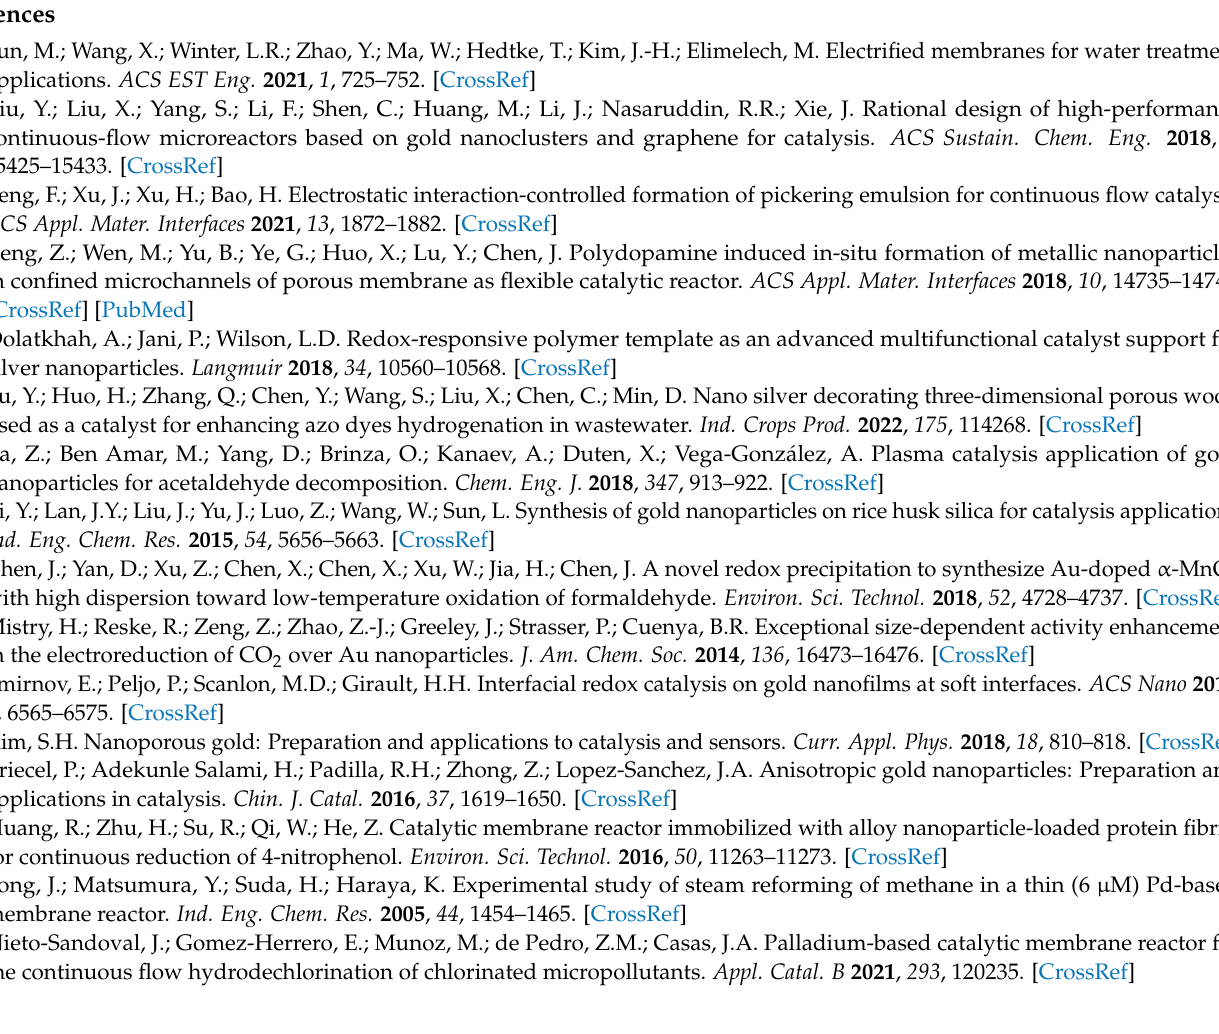
CNT-MoS 2 @Au catalytic membrane; Figure S6: Degradation efficiency of 4-NP by using CNT-MoS 2 membrane, CNT-MoS 2 @Au membrane and CNT-MoS 2 @Pd membrane. Experimental conditions: [4-NP] 0 = 0.1 mM, flow rate = 2.0 mL/min and pH 0 = 8.0; Figure S7: FESEM image of CNT-MoS 2 @Au- 120 membrane (Au loading time, 120 min); Figure S8: Degradation efficiency of bromate by using CNT- MoS 2 membrane and CNT-MoS 2 @Au membrane before and after applying potential. Experimental conditions: [BrO 3 − ] 0 = 0.1 mM, flow rate = 2.0 mL/min and pH 0 = 4.0; Figure S9: Schematic illustration of the flow-through electrocatalytic filtration system; Figure S10: Schematic diagram of electrochemistry-modified Whatman polycarbonate filtration casing; Table S1: Comparison of the 4-NP reduction performance of proposed system with reported catalytic membrane reactor systems; Table S2: The k values related to bromate reduction under different applied potential according to pseudo-first order kinetic model. References [56–60] are cited in the Supplementary